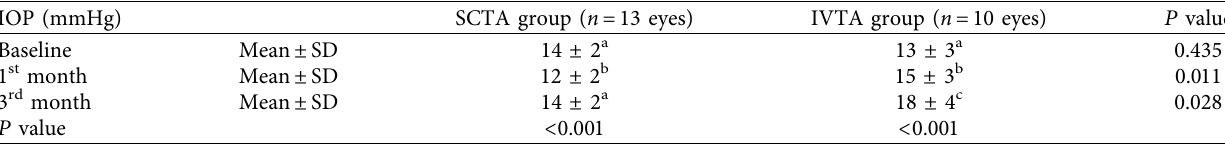
Table 4: IOP in both groups at baseline, one month, and three